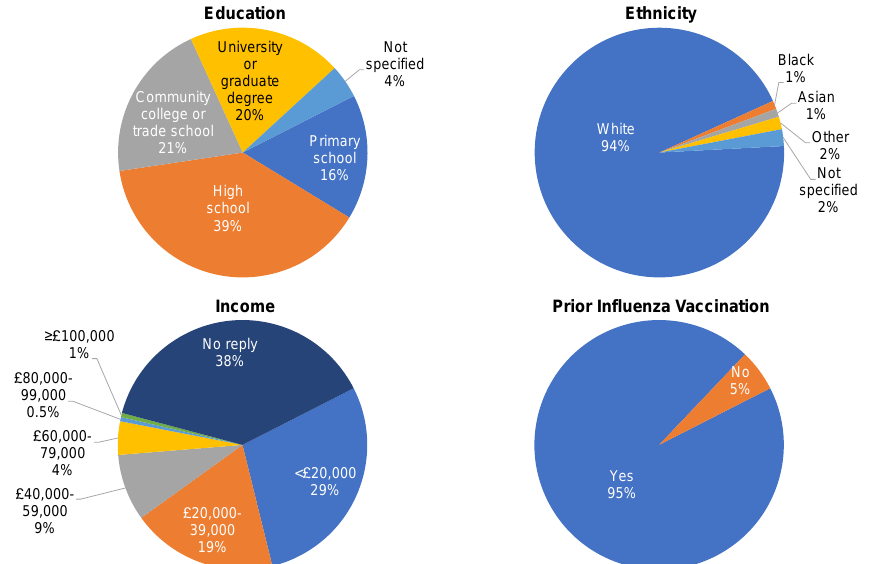
Figure 1. Demographics of the patient population (n = 185). Education refers to the highest level achieved. Income refers to total annual household income. Prior influenza vaccination refers to vaccination during the previous season.